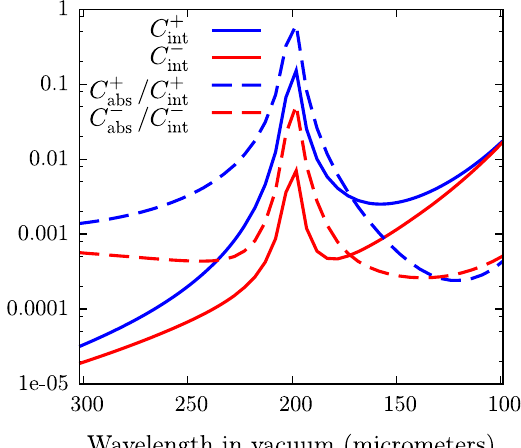
interaction cross sections for each helicity (cid:2) . At 200 μ m, the maximum of em-chirality in Fig. 5, there is non-negligible absorption of the helicity with the dominant